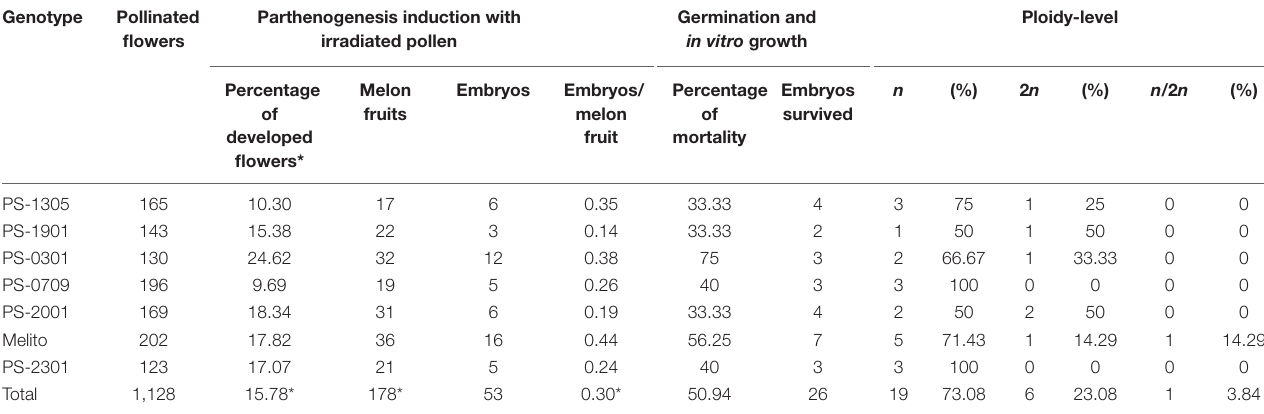
TABLE 2 | Parthenogenetic efficiencies of the seven genotypes of melon “Piel de Sapo.” Genotype Pollinated